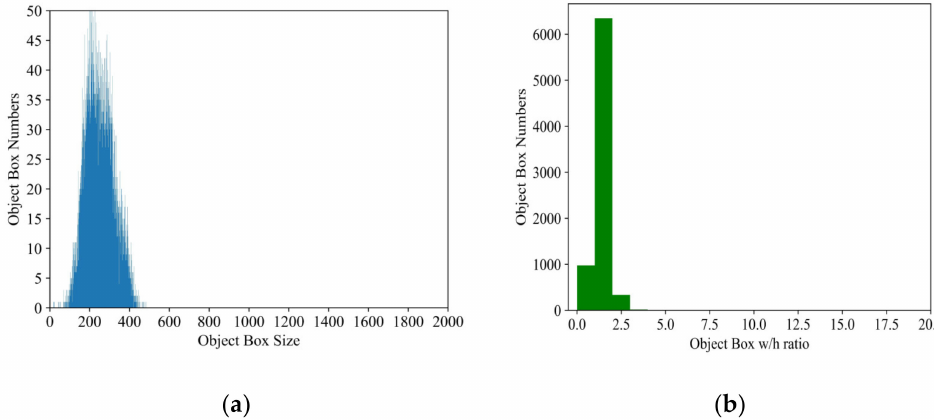
Figure 4. Data distribution. ( a ) the distribution of object box size; ( b ) object w/h ratio distribution.